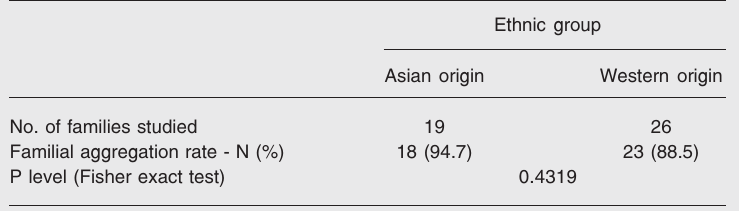
Table 2. Frequency of familial aggregation rate with past or present hepatitis B virus infection as a function of ethnic group.